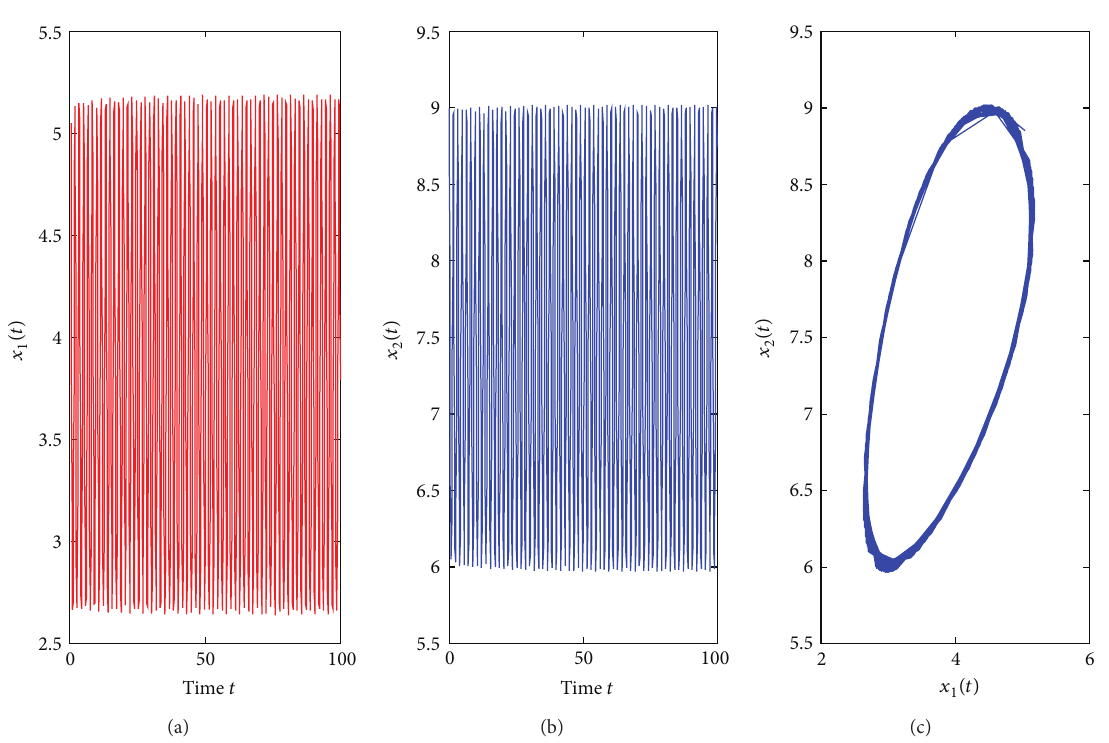
Figure 2: 𝐸 ∗ is unstable for 𝜏 1 = 0.395 > 𝜏 10 = 0.3788